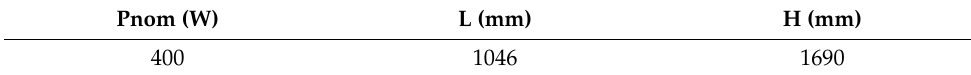
Figure 8. Sunpower Maxeon 3 panel: ( a ) picture of the panel; ( b ) dimensions. Table 4. Features of the chosen